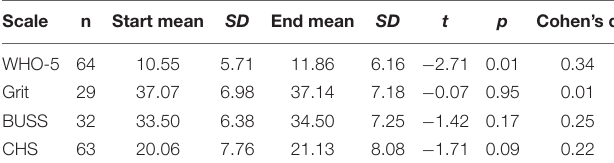
TABLE 1 | Descriptive statistics for pilot